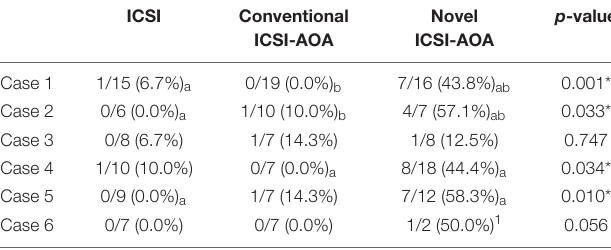
TABLE 2 | The comparison of the fertilization rates using different methods. ICSI Conventional Novel ICSI-AOA